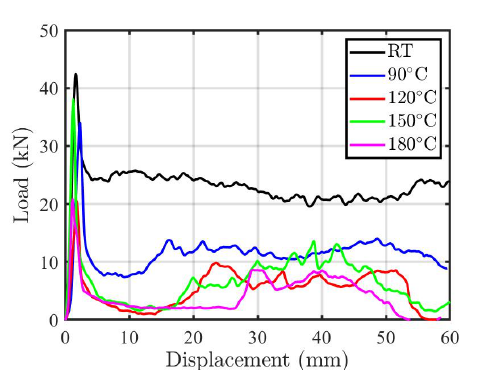
Figure 3. Load-displacement profile of the composite rectangular tubes under crushing after thermal